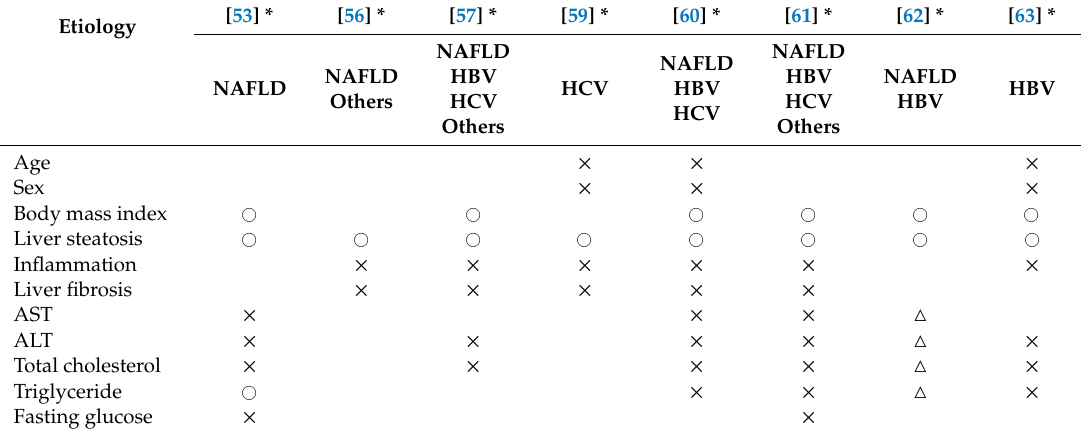
Table 3. Factors a ff ecting CAP measurements.